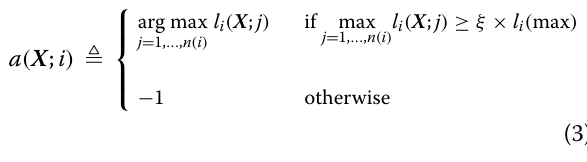
threshold ξ ∈ [ 0, 1] is pre-specified 3 . It is noted that this approach is equivalent to gating the measurement Mahalanobis distance with a threshold √ − 2 ln ξ g =